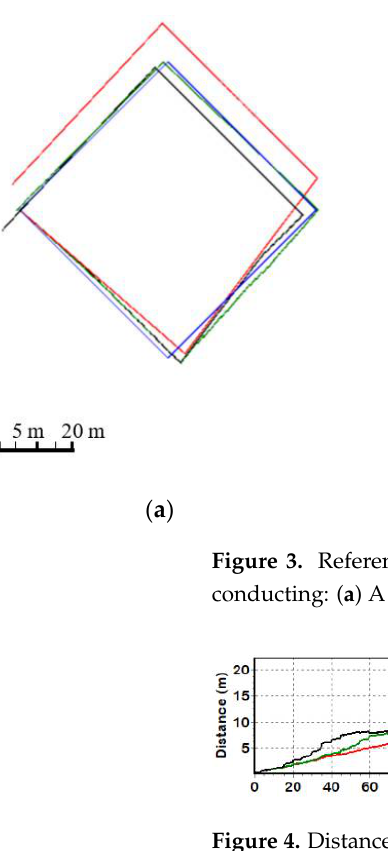
Figure 4. Distance to reference position from positions estimated using DR, GA1, GA2 methods as a function of time (single test sample). Table 1. Statistical parameters describing the change of distance to the reference position from positions estimated using the DR, GA1, and GA2 methods.